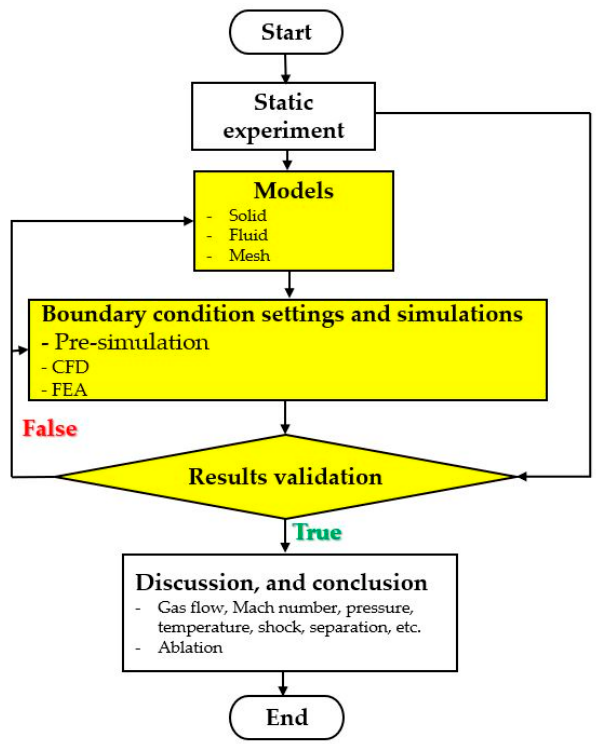
Figure 4. A flowchart of methodology.